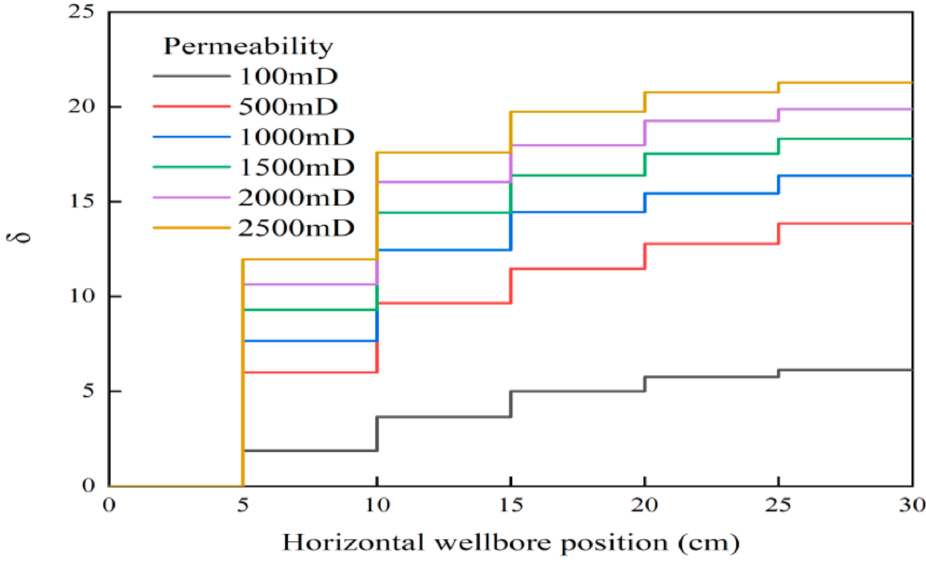
Figure 4. δ distribution along the horizontal well under the influence of the heel–toe